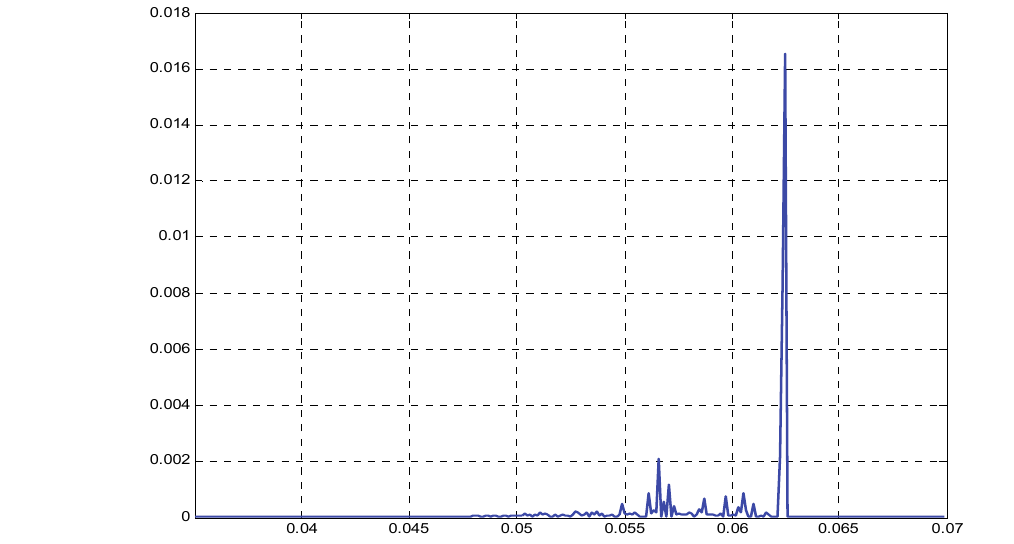
Figure 9: Mean absolute error